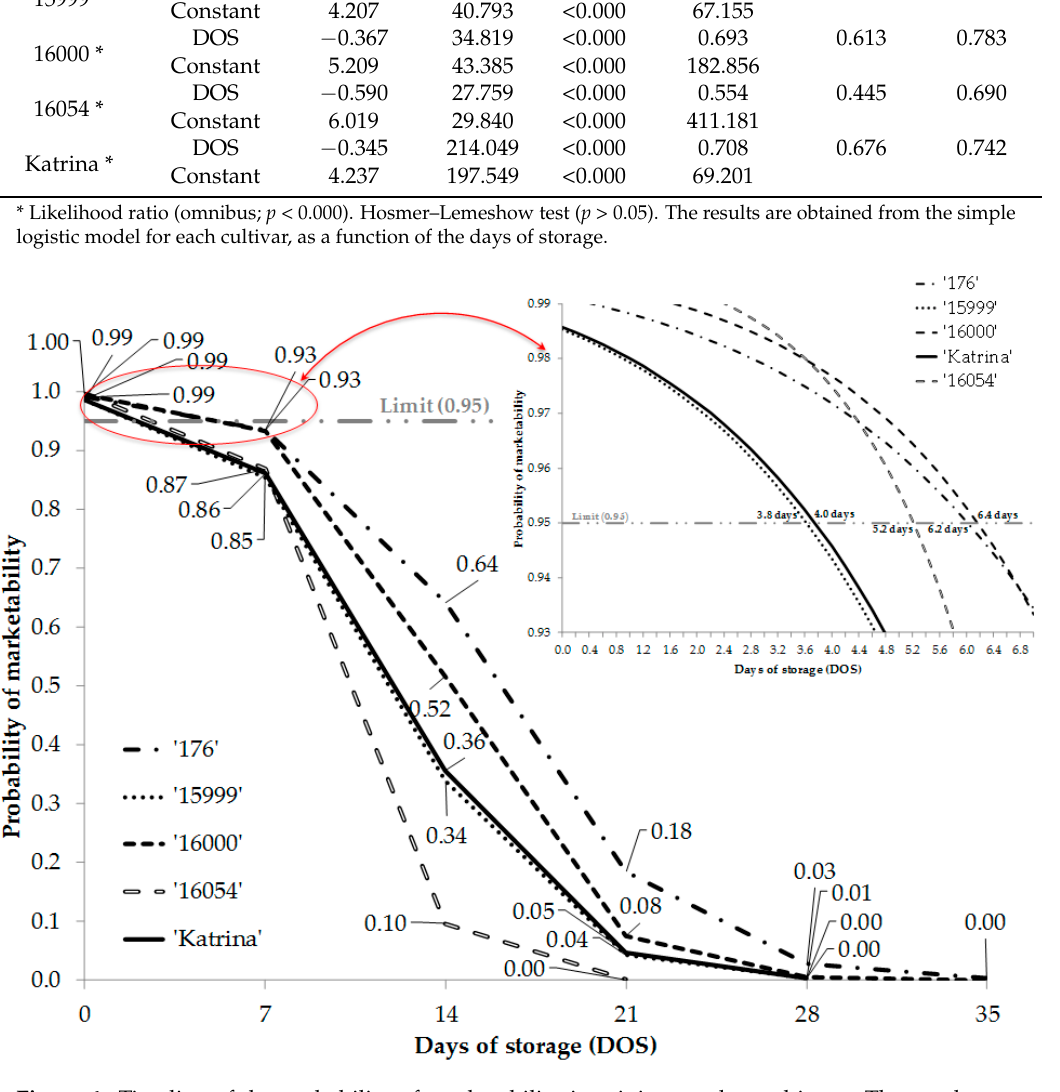
Figure 4. Timeline of the probability of marketability in mini cucumber cultivars. The results are obtained from the simple logistic model for each cultivar, as a function of the days of storage. The odds ratios (Exp ( β )) and their confidence intervals for all cucumber cultivars are shown in Table 2 and Table 3. The value of the confidence interval for Exp ( β ) is never 1, which shows that the DOS variable explains the behavior of the probability of marketability for each cucumber cultivar.